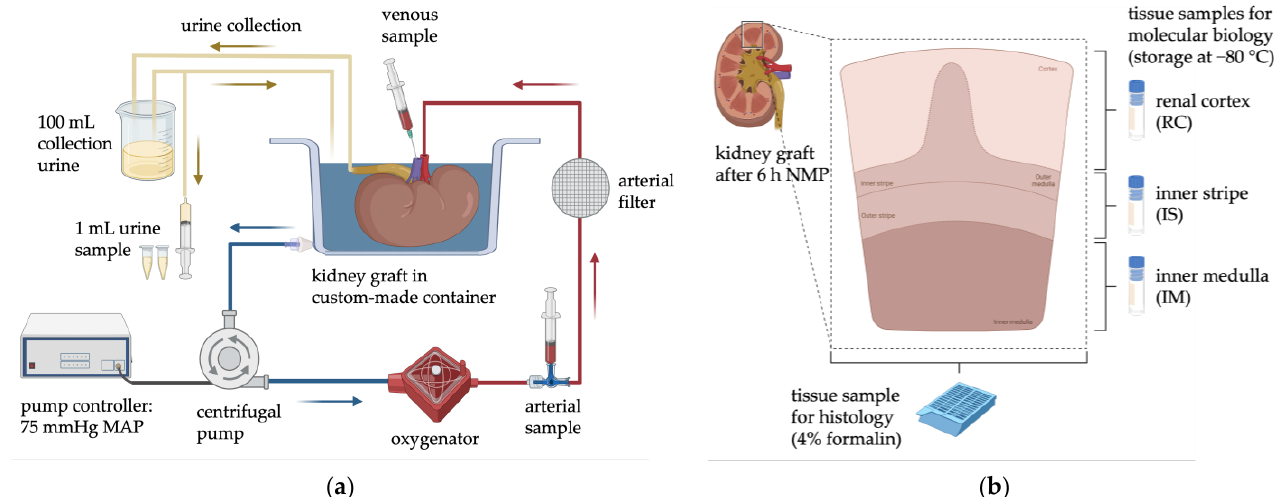
Figure 1. ( a ) Schematic arrangement of the NMP circuit and the sample collection during perfusion. ( b ) Collection of tissue samples for both histology and biomolecular analysis. Created with BioRender.com. (accessed on 24 January